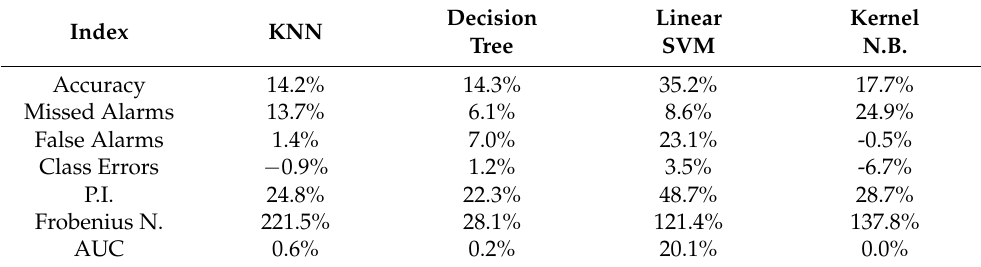
Table 4. Percentage variation of the performance indices obtained with the proposed method and with classifications using the features extracted from the original space. Frobenius Norms and AUC percentages are standardized. Please note that all the percentage variations represent an improvement in performance since the percentage values referring to accuracy, P.I. and AUC indicate an increase in precision, while those referring to Missed Alarms, False Alarms, Class Errors and Frobenius Norms indicate a decrease in errors.